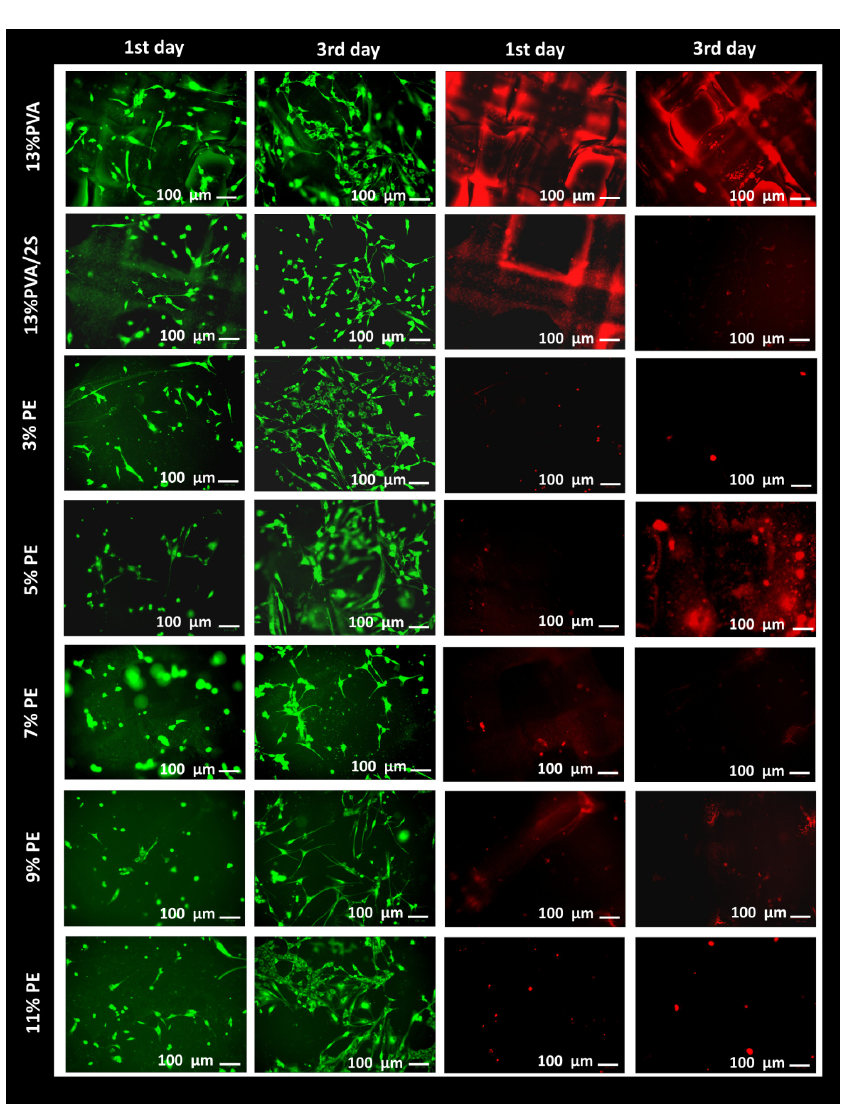
16 of 21 on the 13% PVA/2% S/3% PE scaffold had the highest cell viability, and the 13% PVA/2% S/11% PE scaffold also showed higher cell viability than other scaffolds. The number of cells on the 13% PVA/2% S/11% PE scaffold was nearly the same as the number of cells on the 13% PVA/2% S/3% PE scaffold. Moreover, PI staining showed that cellular apoptosis was not observed for each scaffold. However, cells only on the 13% PVA/2% S/7% PE and 13% PVA/2% S/9% PE scaffolds had lower cellular biocompatibility than the control and other scaffolds due to the different cellular morphologies. Since polymeric materials can